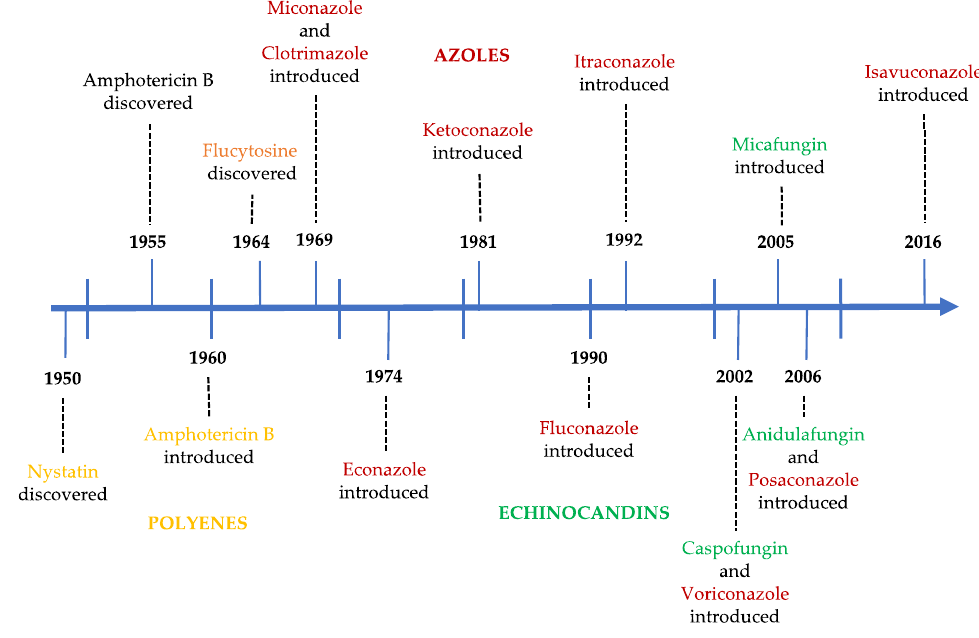
Figure 2. Historical evolution of antifungal agents.